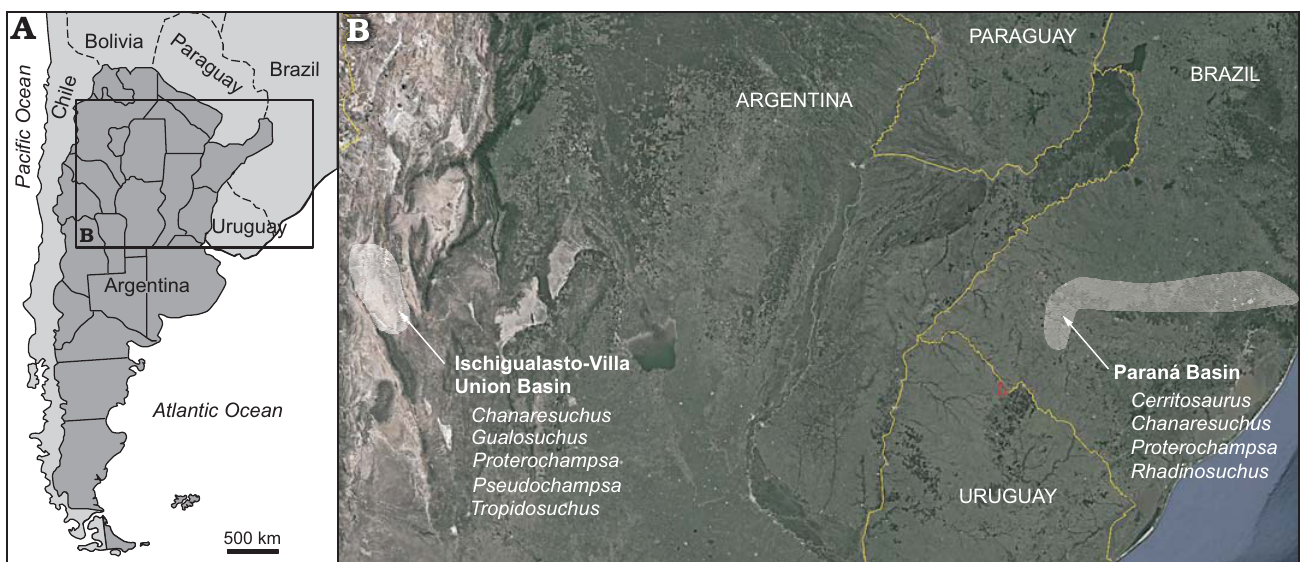
Fig. 1. A . Geographic location of the studied basins. B . Map showing location of Ischigualasto-Villa Union Basin (Argentina) and Paraná Basin (Brazil) and presence of the proterochampsids taxa. Satellite image taken from Google